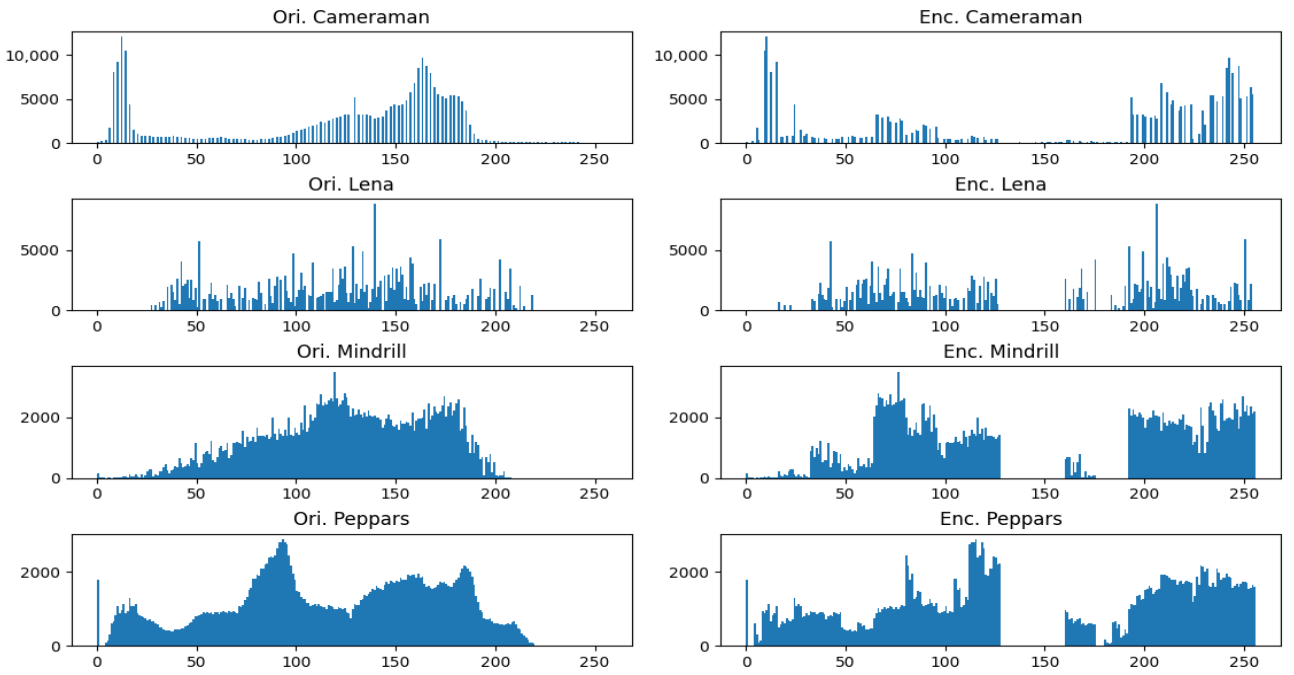
Figure A1. Histograms of multiple test images. On the left are original images histograms and on the right are encrypted images histograms.